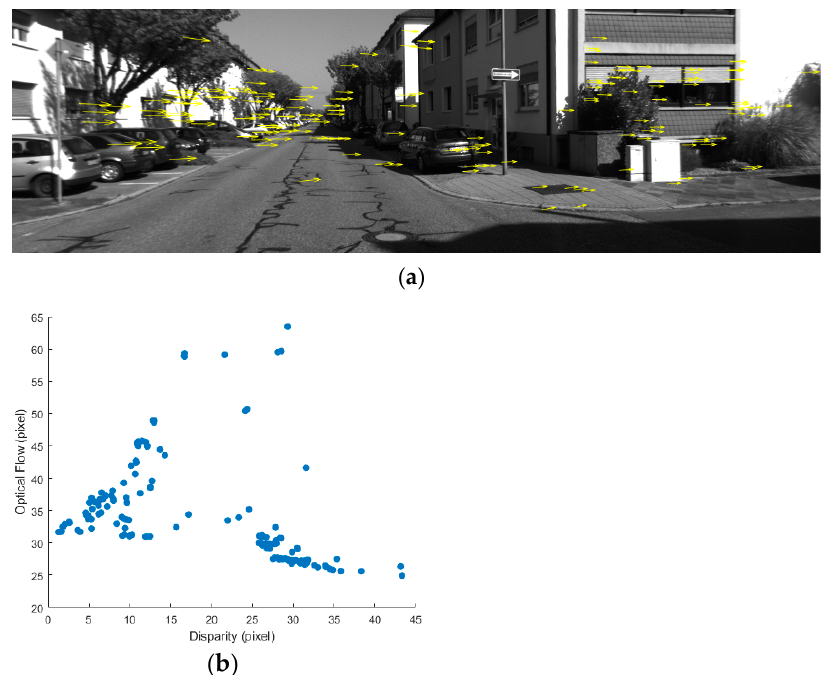
Figure 4. ( a ): Feature point tracking results in frame 99 on sequence 00 of the KITTI odometry dataset. The yellow arrow indicates the optical flow vector of the feature point. ( b ): Relationship between the disparity and the optical flow for a turning maneuver; regardless of the size of the disparity, all features have large motion. Each blue dot corresponds to a feature point in ( a ).